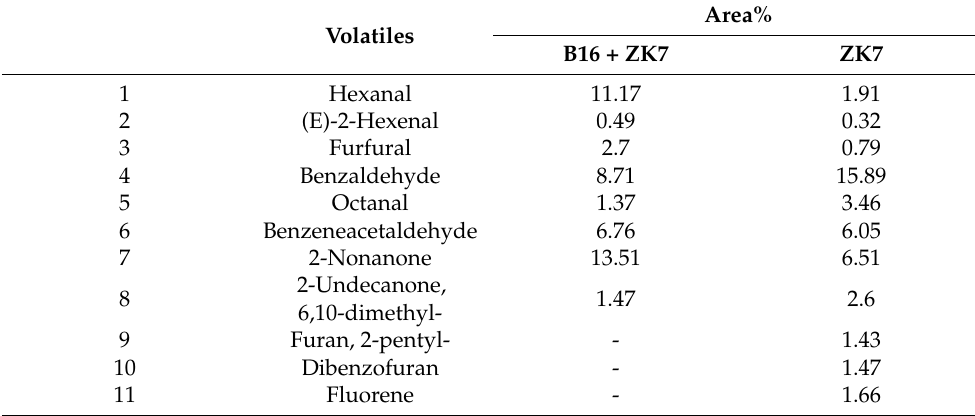
Table 7. Volatile matters in soil.